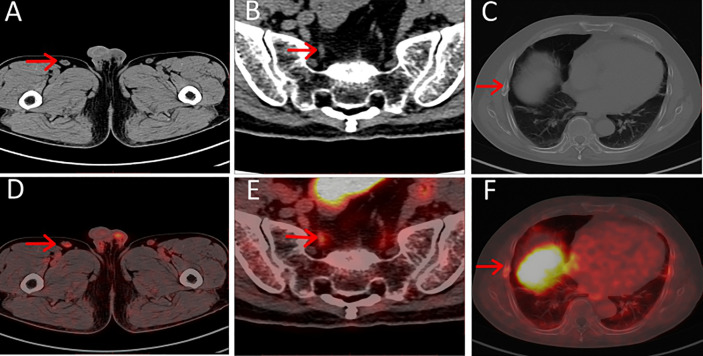
(A–C) Axial CT, (D–F) axial PET/CT of pitfalls in 18F-PSMA-1007. Unspecific PSMA-ligand uptake in right inguinal lymph node (A, D), PSMA-ligand uptake in pelvic ganglia (B, E) and PSMA-ligand uptake in right non-displaced rib fracture (C, F).